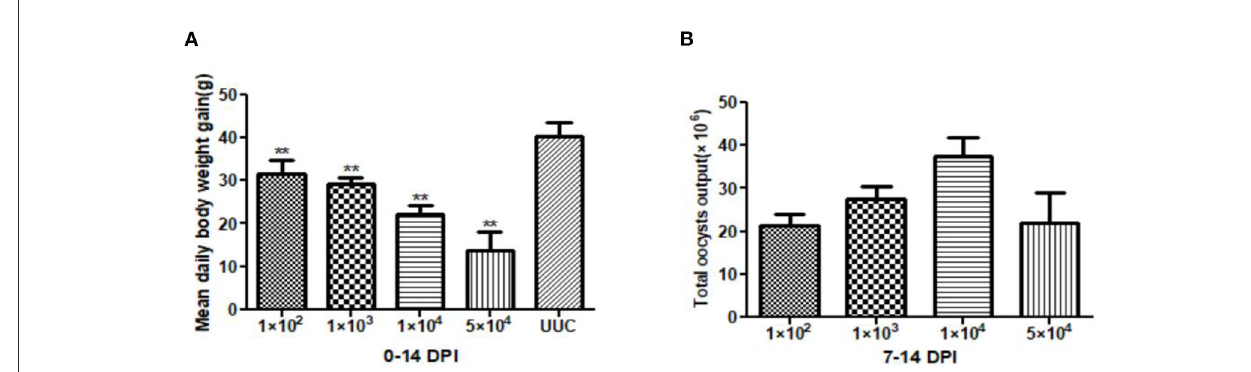
FIGURE1 Average daily weight gain of rabbits and total oocyst output in pathogenicity tests. (A) Average daily weight gain of rabbits 0–14 days after initial oocyst inoculation. (B) Total oocyst output 7–14 days after inoculation with different doses of sporulated E. kongi oocysts. DPI: day post initial inoculation. ** P < 0.01 (Student’s t -test).